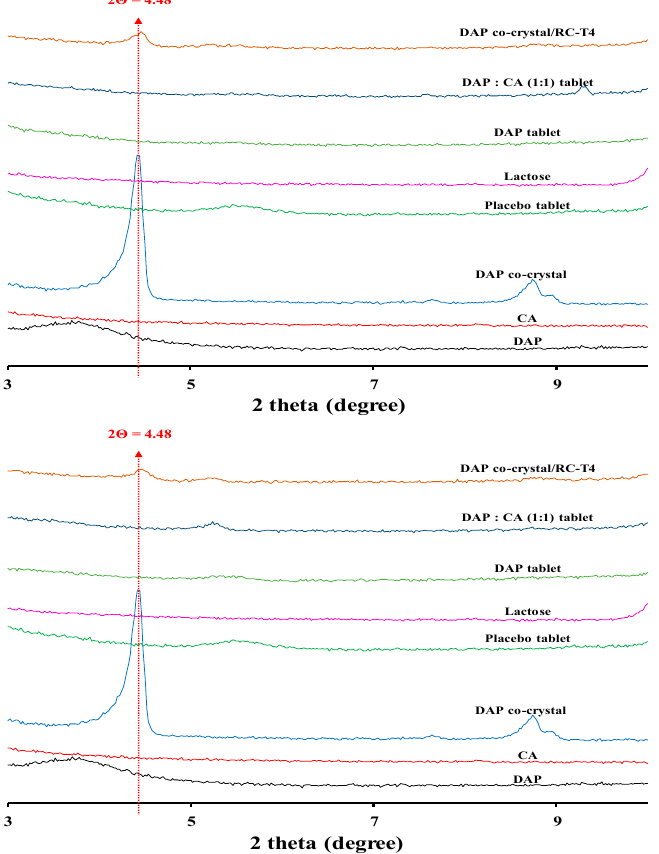
Figure 4. X-ray diffraction (XRD) patterns of RC-T4 with various groups under the long-term (top, 6 months) and accelerated condition (bottom, 6 months).